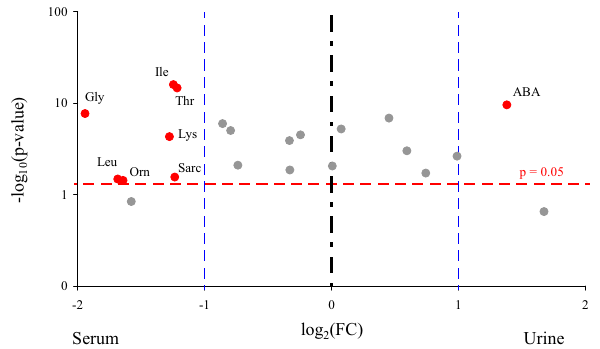
Figure 1. Volcano plot indicating the amino acids with the most meaningful changes analyzed in the serum and urine of the control group based on univariate analysis—y-axis: Mann–Whitney p value, x-axis: fold change (FC). Each dot represents one amino acid. The amino acids with significance p < 0.05 are located above the red horizontal line. The amino acids with more than a twofold change of a concentration are located on right and left from the respective blue right and left vertical lines. Only red dots indicate amino acids with the clinical and statistical differences. ABA, α-aminoisobutyric acid; Gly, glycine; Ile, isoleucine; Leu, leucine; Lys, lysine; Orn, ornithine; Sarc, sarcosine; Thr, threonine; p , significant value.